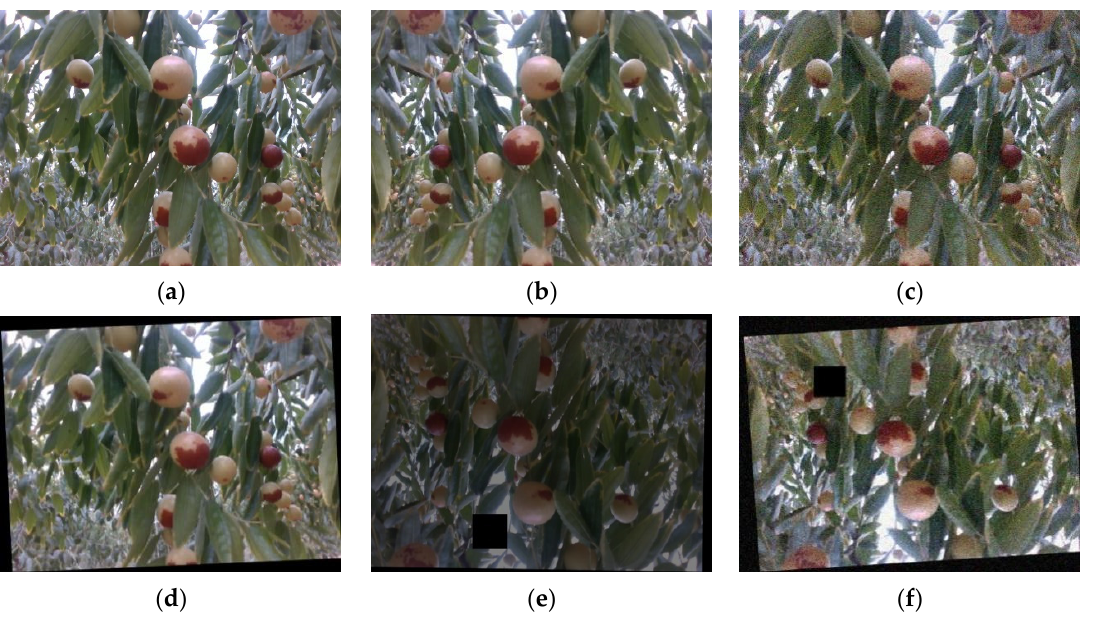
Figure 2. Image sample after data expansion. ( a ) Original image; ( b ) Mirroring image; ( c ) Adding noise; ( d ) Rotation; ( e ) Rotation + Reduced brightness + erasure; ( f ) Adding noise + Rotation + erasure.